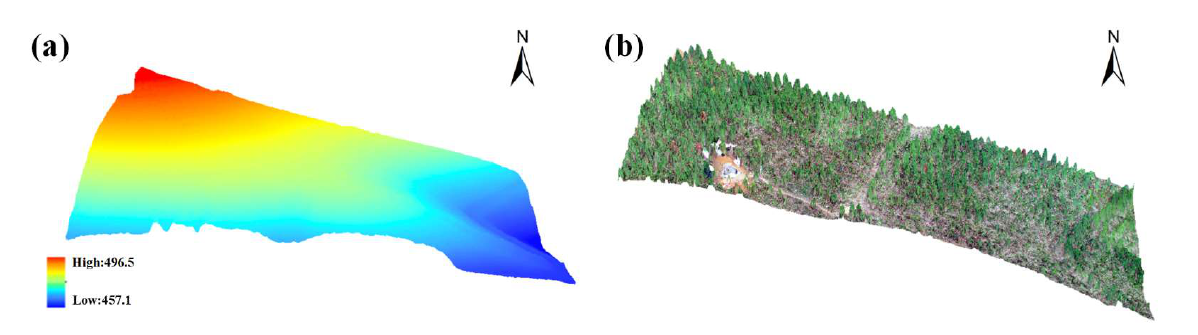
Figure 3. DEM derived from UAV images ( a ) and 3D visualization of UAV image in 2021 overlayed DEM ( b ) in the study area.